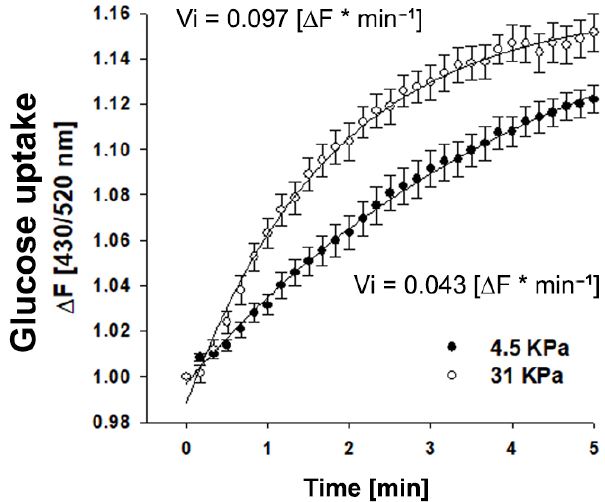
Figure 2. Glucose uptake is favored in mammary stromal cells cultured in rigid matrices. Time course curve of glucose incorporation measured as the fluorescence ratio of FLIPglu-60060Δ6 biosensor in RMF-621 cells cultivated for 4 days on coverslips coated with an elastic polyacrylamide gel, to which type I collagen (50 µg/cm 2 ) was covalently cross-linked and exposed to 5 mM glucose. Fluorescence was recorded every 10 sec. Open circles correspond to cells cultured on a soft matrix (4.5 KPa), and closed circles to cells cultured on a stiffer matrix (31 KPa). The data correspond to an average of almost 20 single cells recorded in four independent experiments. The continuous line represents the best fit of a double rectangular hyperbola, and the Vi values were estimated from the slope of each glucose uptake curve.